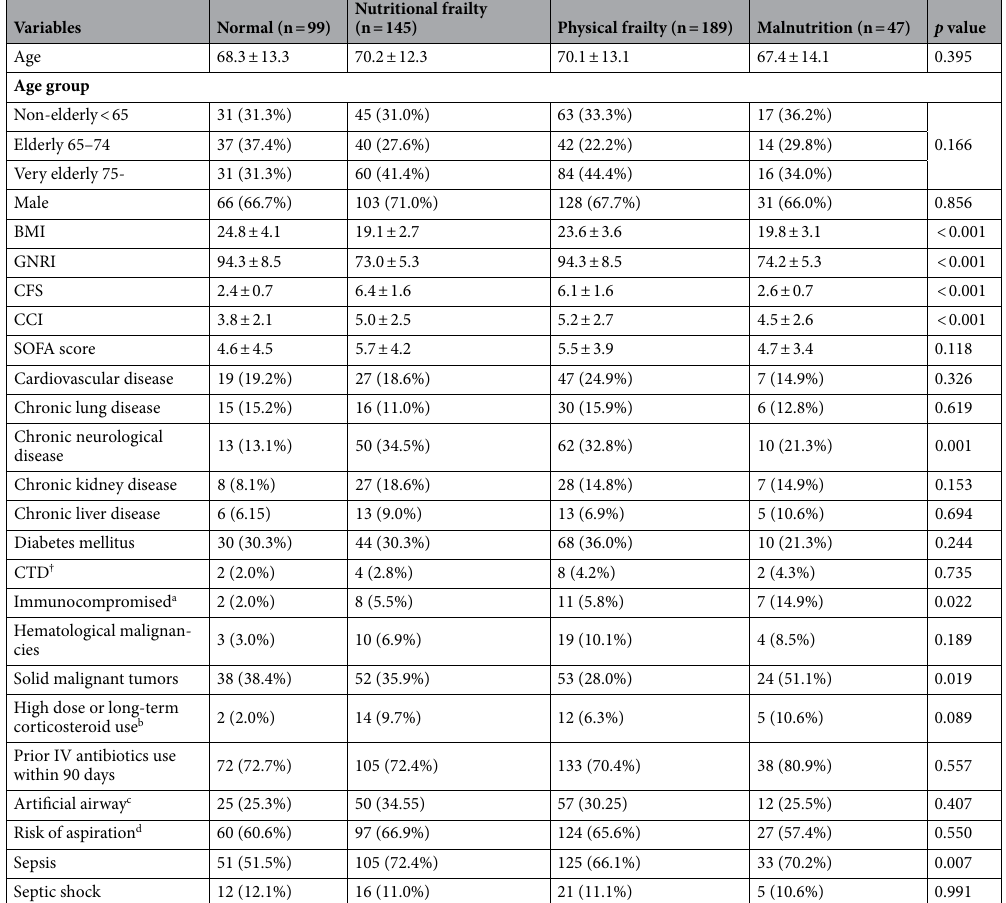
Scale, CCI Charlson Comorbidity Index, SOFA sequential organ failure assessment, CTD connective tissue disease, IV intravenous. a HIV-infected patients with CD4 + counts of less than 200 cells/mm 3 , neutrophil counts of less than 1000 cells/mm 3 , or patients taking immunosuppressive drugs after organ transplantation. b Prednisone 20 mg/day or its equivalent taken for at least 2 weeks. c Tracheostomy tube, tracheal tube, and others. d Impaired swallowing (esophageal disease, neurologic disease, and recent extubation),